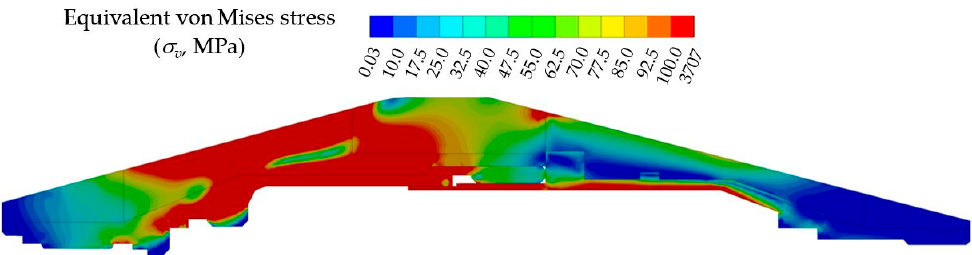
Figure 18. The σ v on the solid domain calculated from the CHTA.